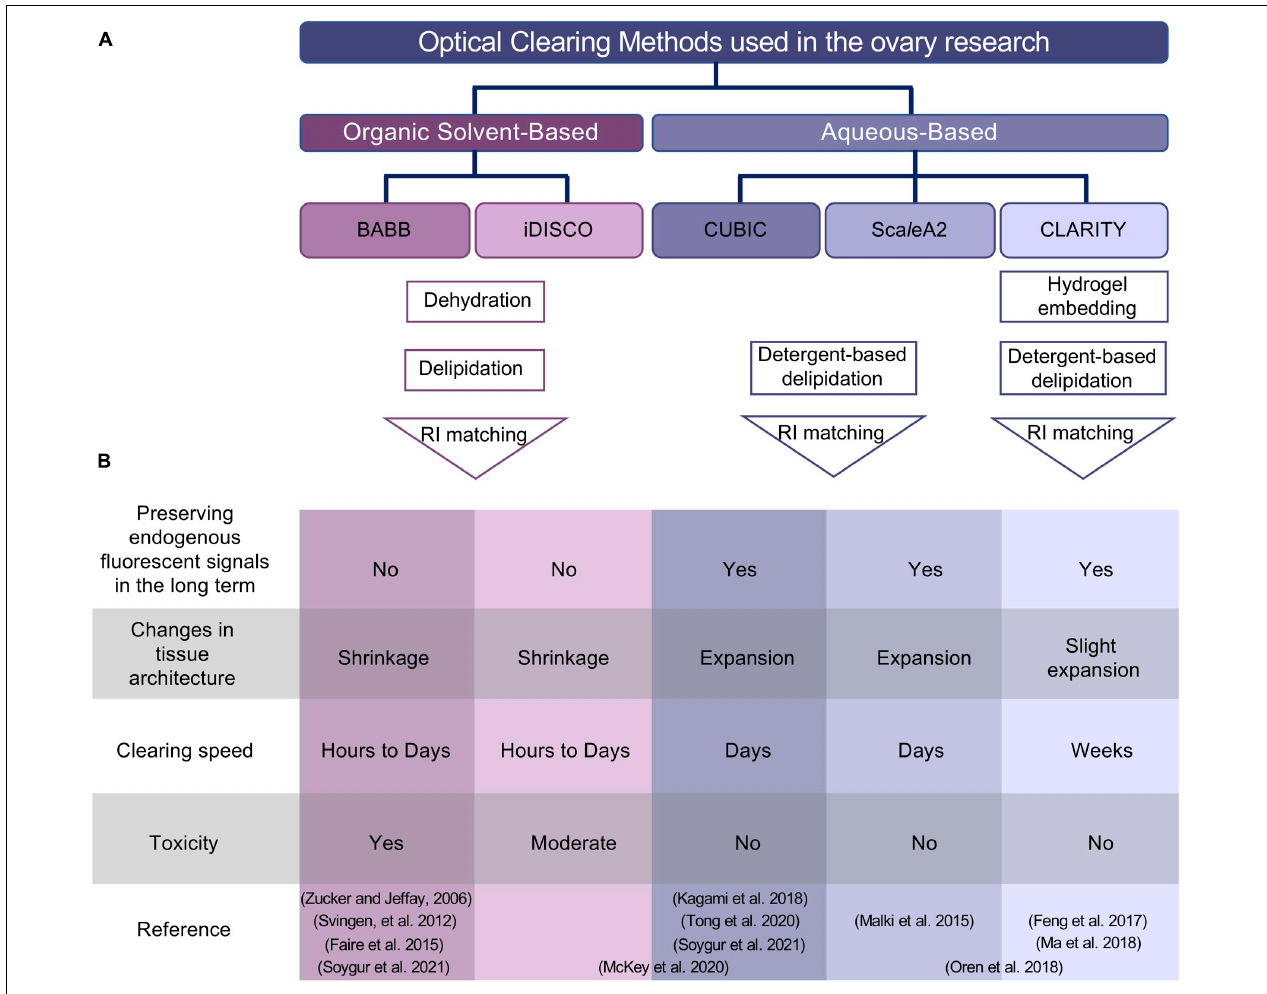
FIGURE 2 | Summary of optical clearing methods applied to the ovary. (A) Outline of organic solvent-based and aqueous-based clearing approaches. Despite the use of different reagents in two different (BABB and iDISCO) organic solvent-based clearing methods, both protocols involve dehydration, delipidation, and a final RI matching step. Aqueous-based approaches (CUBIC and Sca l eA2) use high concentrations of detergents to remove lipids, while hydrogel embedding of the sample in CLARITY protocol maintains tissue and protein structure before incubation with high concentration of detergents to remove lipids. (B) Comparison of different methods based on experimental specifications. Studies used combined approaches are placed spanning the columns for iDISCO and CUBIC or Sca l eA2 and CLARITY in the reference column. BABB, benzyl alcohol and benzyl benzoate; iDISCO, immunolabeling-enabled three-dimensional imaging of solvent-cleared organs; CUBIC, clear, unobstructed brain/body imaging cocktails and computational analysis; CLARITY, clear lipid-exchanged acrylamide-hybridized rigid imaging/immunostaining/ in situ -hybridization-compatible tissue hydrogel; RI, refractive